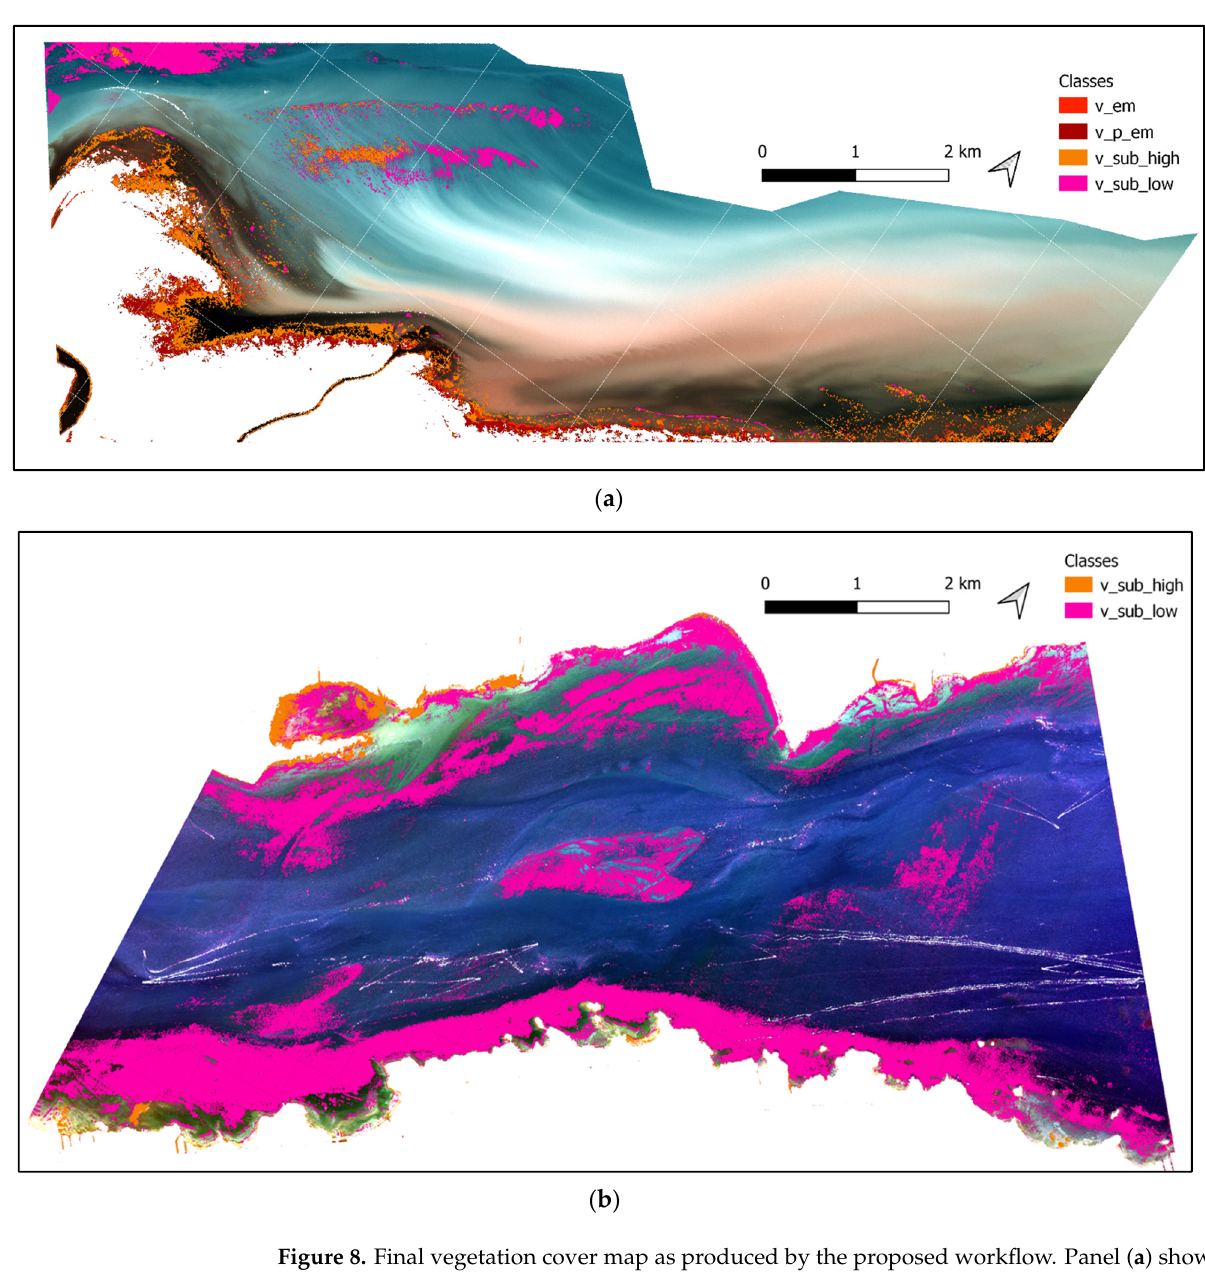
14 of 23 Figure 7. Visualization of the iterative classification process over image 1, the 2009 lake Saint-Pierre Quickbird-2 image (© 2022 Maxar Technologies). From top to bottom, we see the first to the last